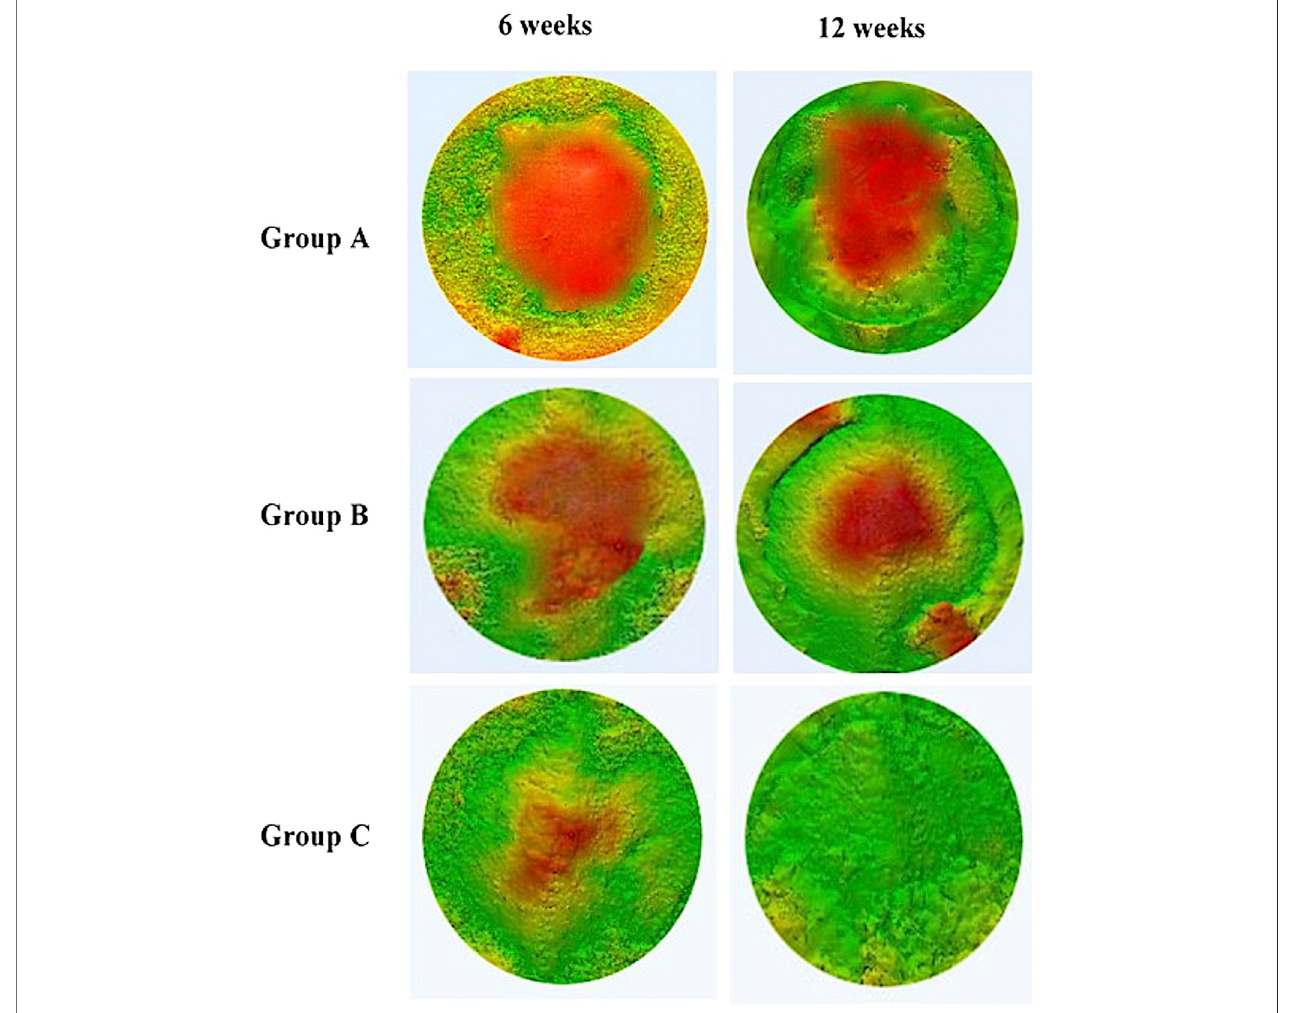
FIGURE 6 | Comparison of 3D color map of different groups (group A (control), group B (chitosan gel), group C (OPG-chitosan gel)) at 6 and 12 weeks after treatments.